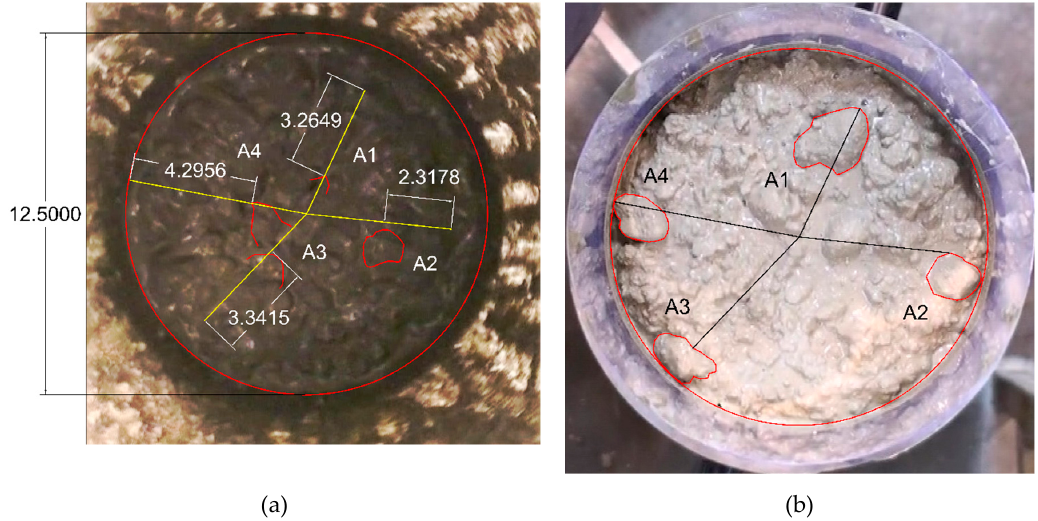
Figure 3. Displacement of four coarse aggregates in C47 between two frames no. ( a ) #90 and ( b ) #110; vertical velocity in the Sliper test was 0.72 m/s.